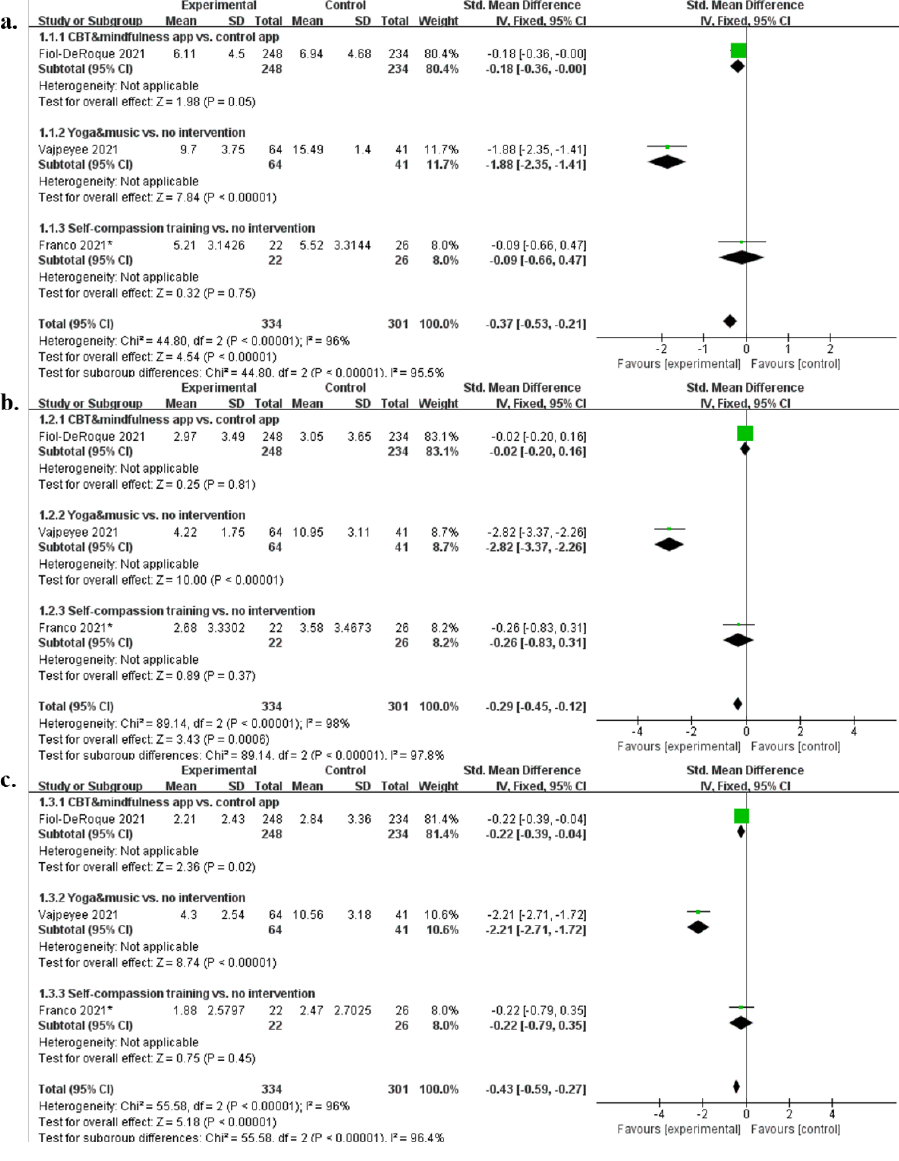
Figure 2. Meta-analysis results of Depression, Anxiety and Stress Scale: ( a ) stress; ( b ) depression; and ( c ) anxiety. Note. *, non-randomized controlled clinical trials.